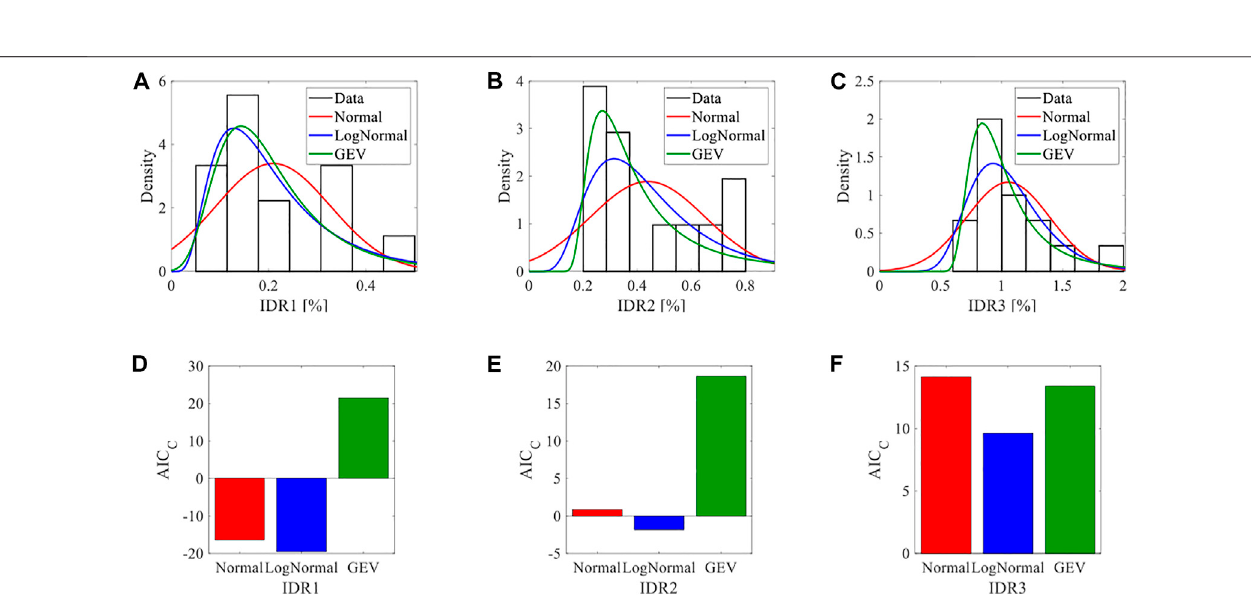
FIGURE 5 | Plot data gathered for IDR thresholds for DS1, DS2, and DS3 (A,B,C) , and AIC C values for the fi ts (D,E,F) , respectively.